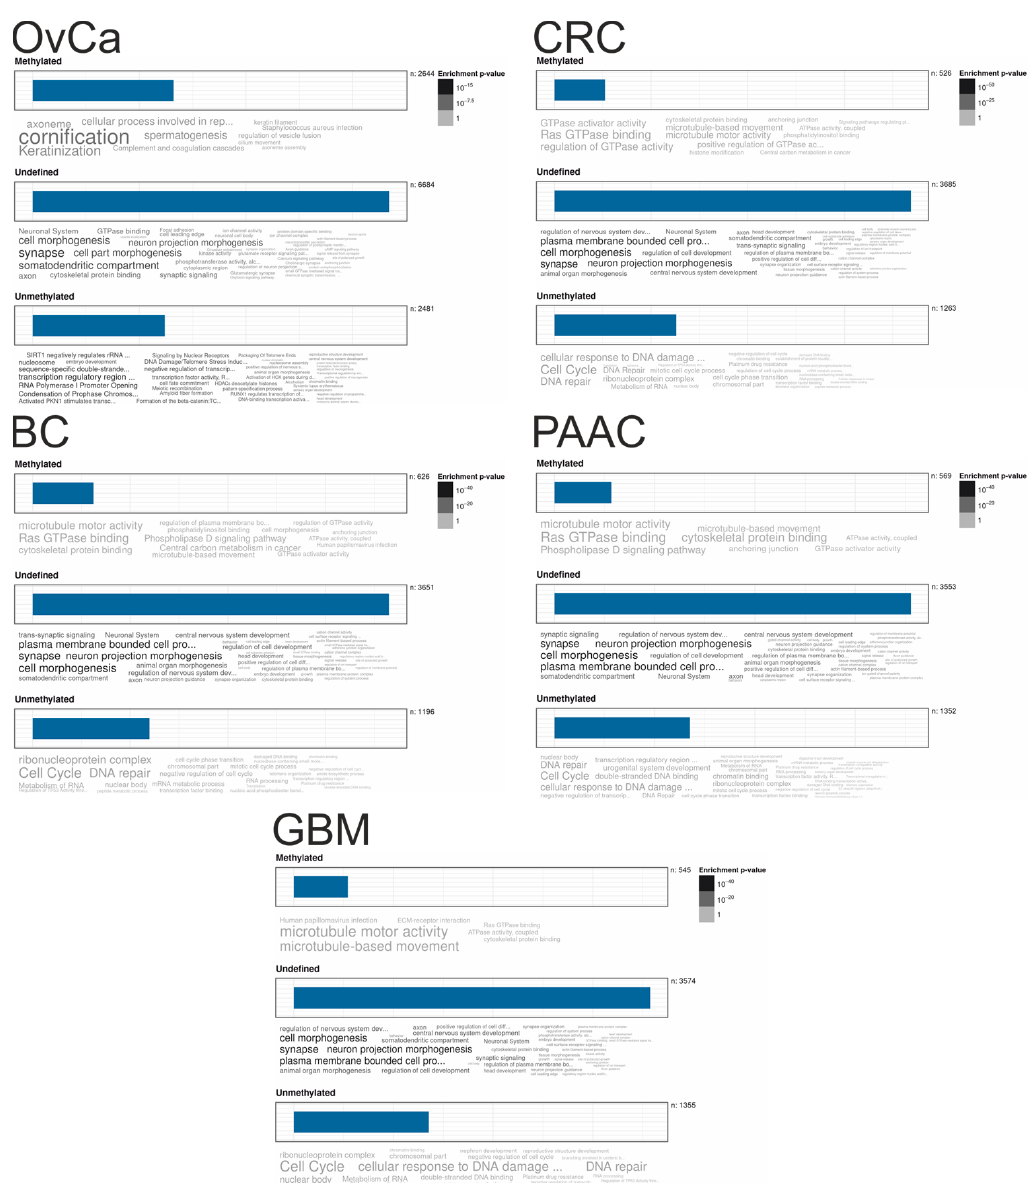
Figure 5. Enrichment plots of gene ontology terms and pathways are shown for lists of genes preferentially (averaged over all samples from each cancer type) methylated (averaged betas > 0.7), unmethylated (averaged betas < 0.3) or undefined methylated (averaged betas between 0.3 and 0.7). Enrichments are indicated in word clouds by size and color ( p -values). Overlap of gene lists are shown in Figure S11.